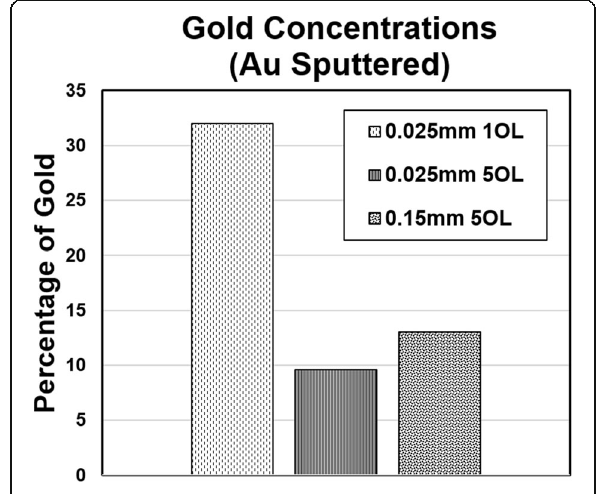
Fig. 12 Gold concentrations found on laser processed silicon sputtered with gold for 8 min at 1 OL 0.025 mm, 5 OL 0.025 mm, and 5 OL 0.15